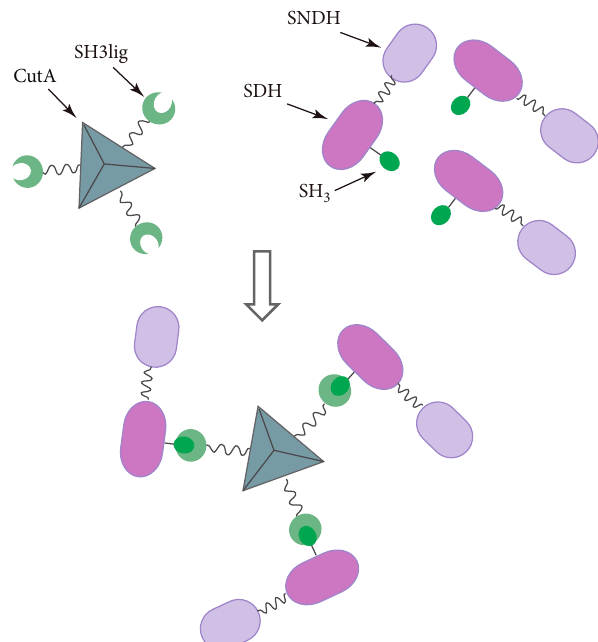
Figure 3: The scheme of protein expression based on the trimeric protein CutA. A longer protein chain with the trimeric CutA was generated under the use of the adaptor protein SH3 and its ligand SH3 lig as docking protein and docking station peptide,